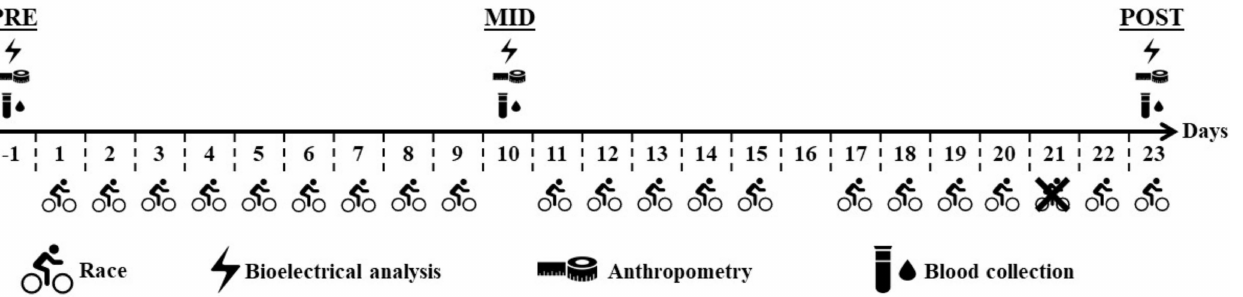
Figure 1. Graphical design of the study. PRE, first assessment one day before the start of the race; MID, second assessment at the middle of the race; POST, last assessment at the end of the